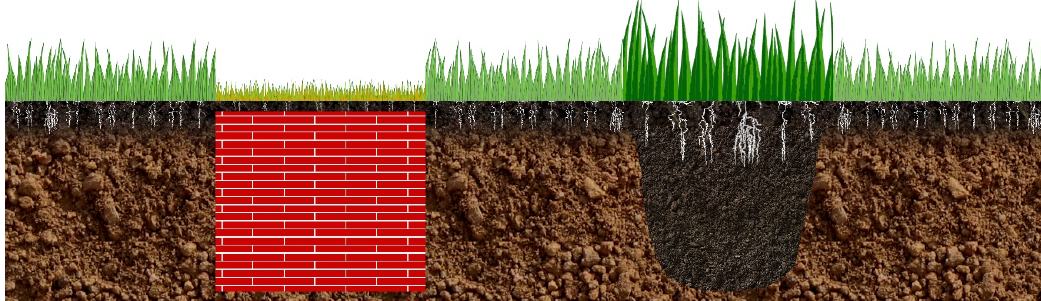
Figure 5. A diagram inserted in “Task Presenter” showing the physical mechanism of negative (left) and positive (right) cropmarks. The image is a modified version of the figure published by Stewart, 2017 [15].